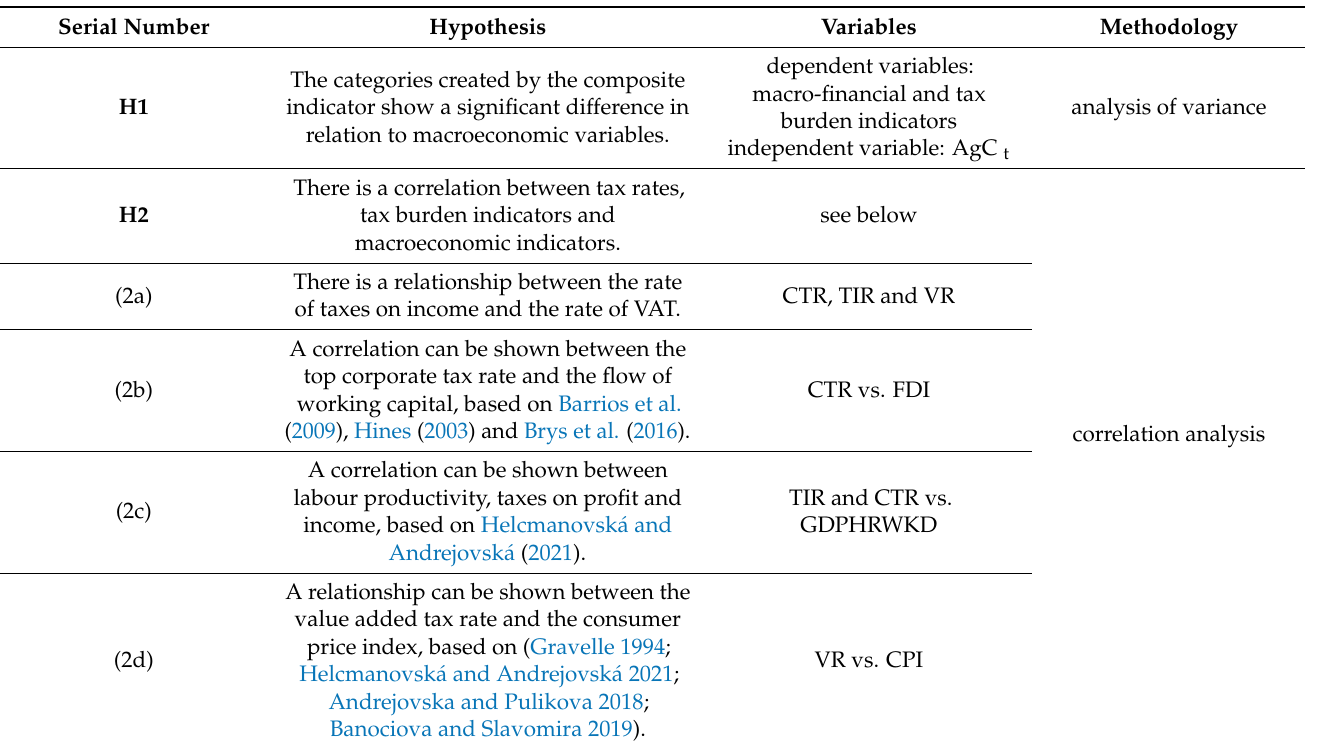
Table 3. Presentation of the research